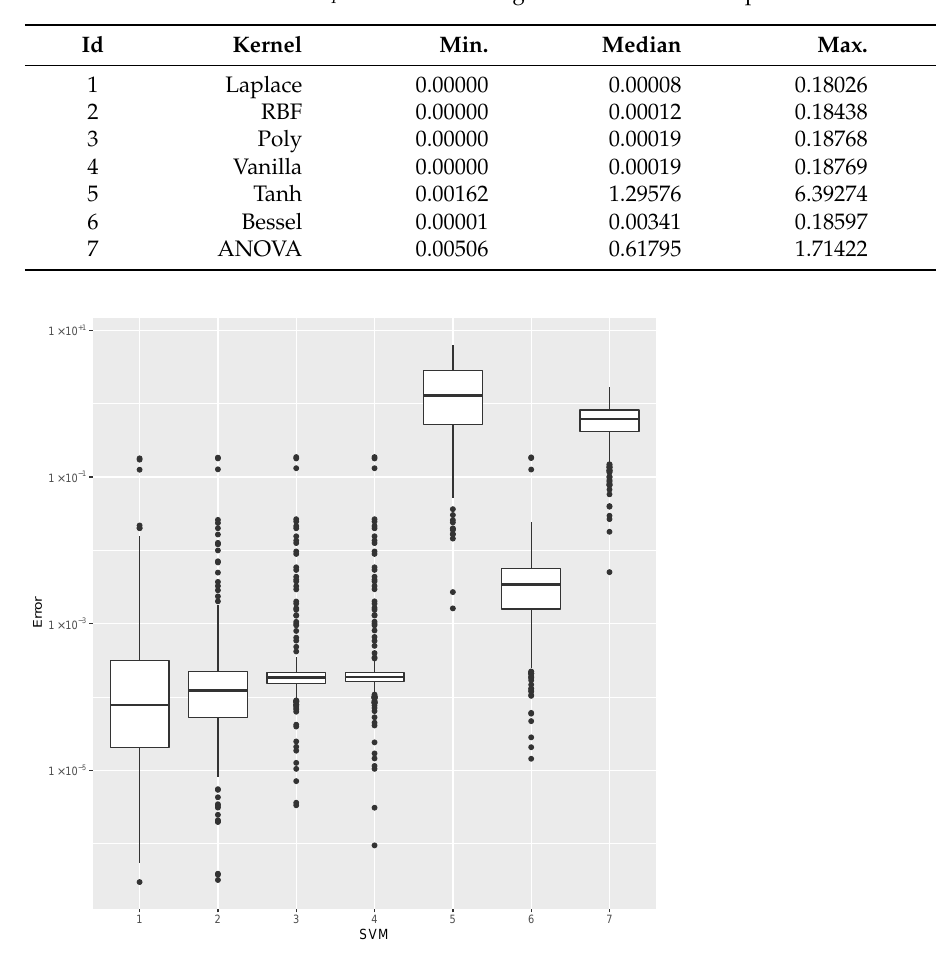
Figure 5. Error dispersion of the b I estimate using distinct SVM kernel options. For the mass estimation, the minimum error, the median error, and the maximum error are shown in Table 2. The error dispersion of the mass estimates using all SVM methods are compared in Figure 6. Based on the median error, the Laplace kernel is the best b I predictor. For the estimation of P critical , the minimum error, the median error, and the maximum error are shown in Table 3. The error dispersion of the P critical estimate is shown in Figure 7. The Laplace kernel is the best P critical predictor, based on the median error. According to the metric of the median error, the SVM combined with the Laplace kernel is the best predictor for the design space created under the proposed parameterization of variable-stiffness cylinders. Table 2. Error statistics of the mass estimate using distinct SVM kernel